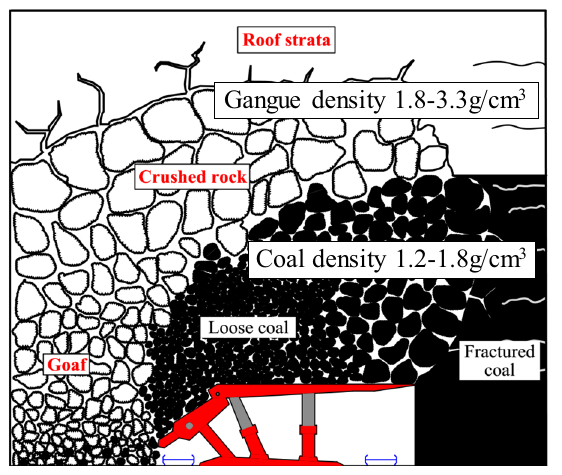
Fig. 1 Schematic diagram of a coal mine showing the gangue and coal (Wang et al. 2016a)